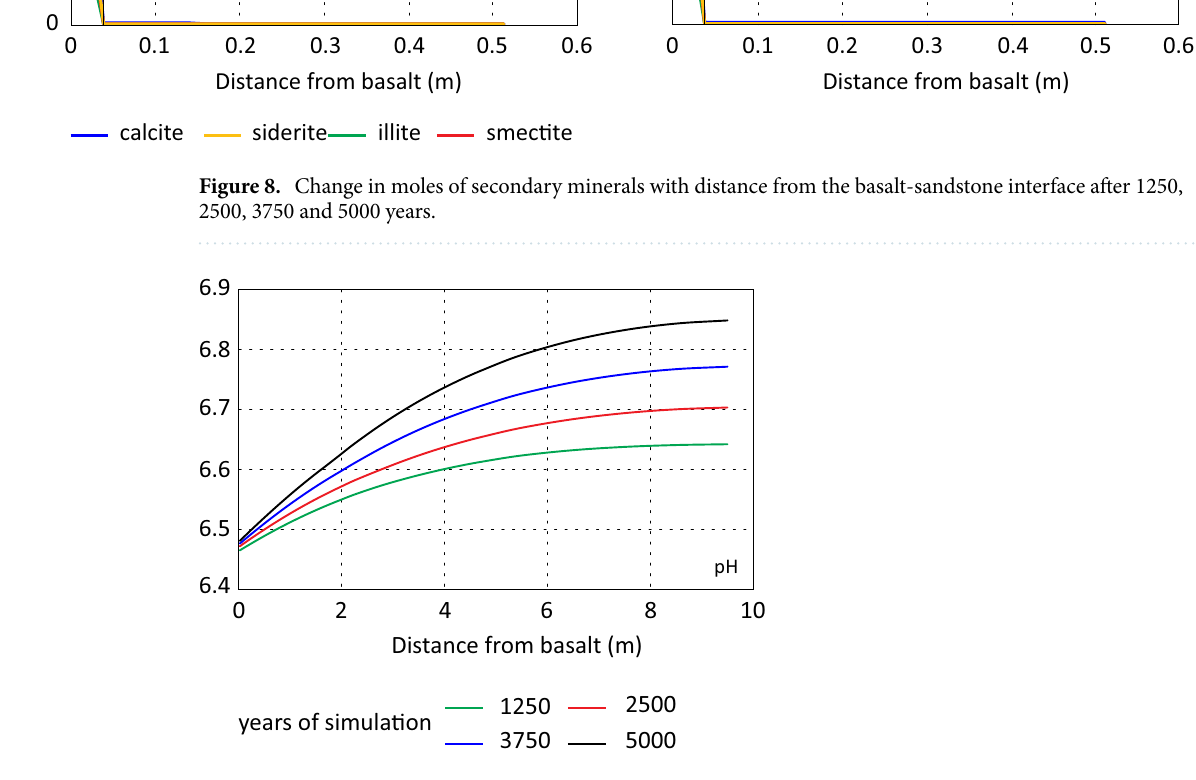
Figure 9. Temporal and spatial evolution of